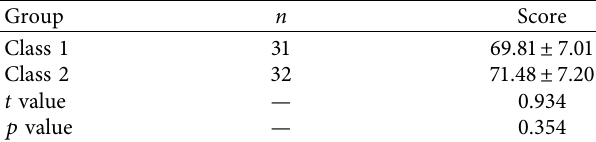
Table 2: Comparison of the theoretical examination results of internal medicine courses between the two classes of students.